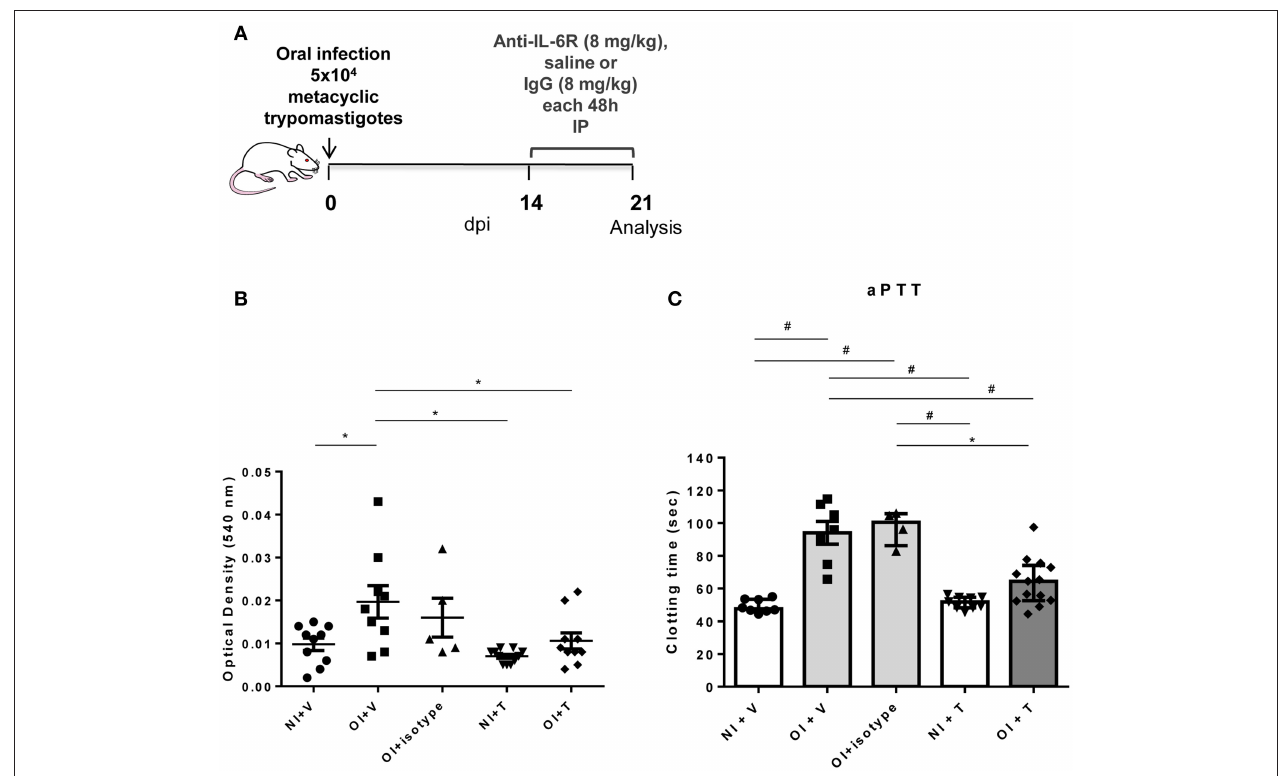
FIGURE 4 | Experimental design, coagulation test aPTT and tail bleeding assay in NI + V, OI + V, OI + isotype, NI + T and OI + T mice. (A) Male BALB/c mice were infected with 5 × 10 4 insect-derived metacyclic forms of T. cruzi (Tulahuén strain) within the oral cavity. Anti-IL6R or IgG treatment began after 14 dpi and was performed in each 48h. (B) Bleeding was caused by a tail transection in NI + Vehicle (NI + V), OI + V, OI + isotype, NI + treatment (NI + T) and OI + T. Absorbance at 540nm (hemoglobin concentration) was used to estimate blood loss. (C) NI + V, OI + V, OI + isotype, NI + T and OI + T plasma were obtained by cardiac puncture followed by addition of the aPTT reagent as described in the “Methods” section. Clotting time was estimated using a coagulometer. (B,C) Values are presented as mean ± SEM for each group/day post-infection and are representative of three independent experiments. Results were analyzed using one way ANOVA with Tukey’s multiple comparisons test (*0.0001 < p < 0.05; # p <